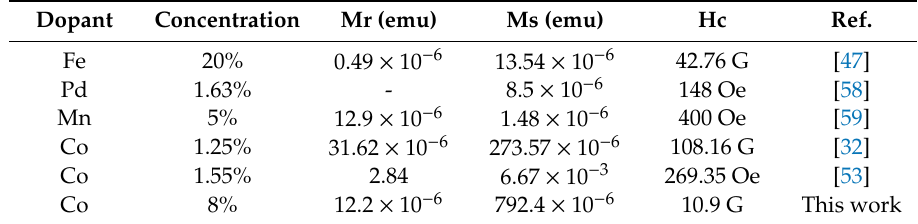
Table 2. Comparison of magnetic properties of di ff erent doped magnetic ions in GaN nanowires.